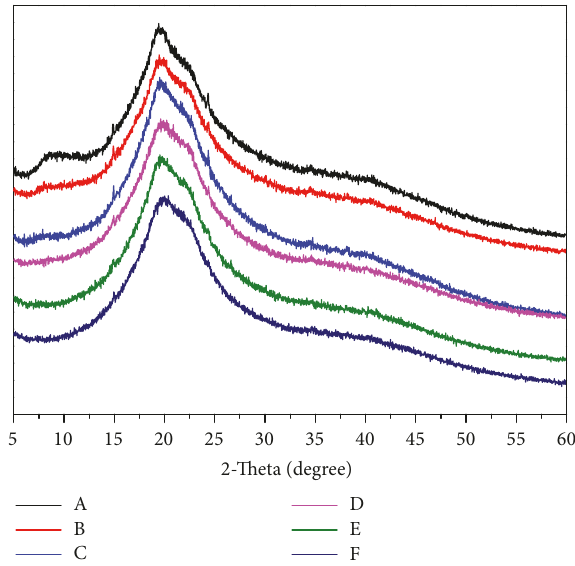
Figure 4: XRD diffraction patterns of unmodified and EGDE- modified SF